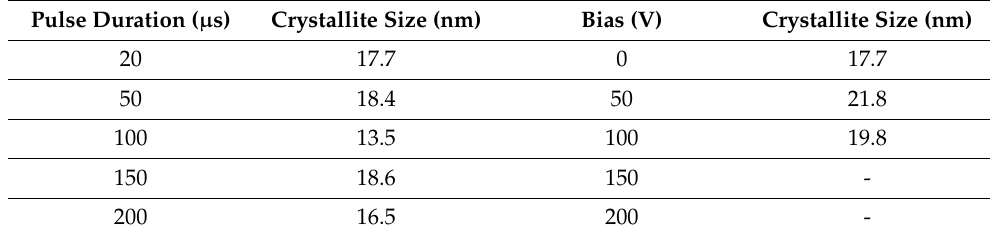
Table 3. Crystallite size estimation of deposited